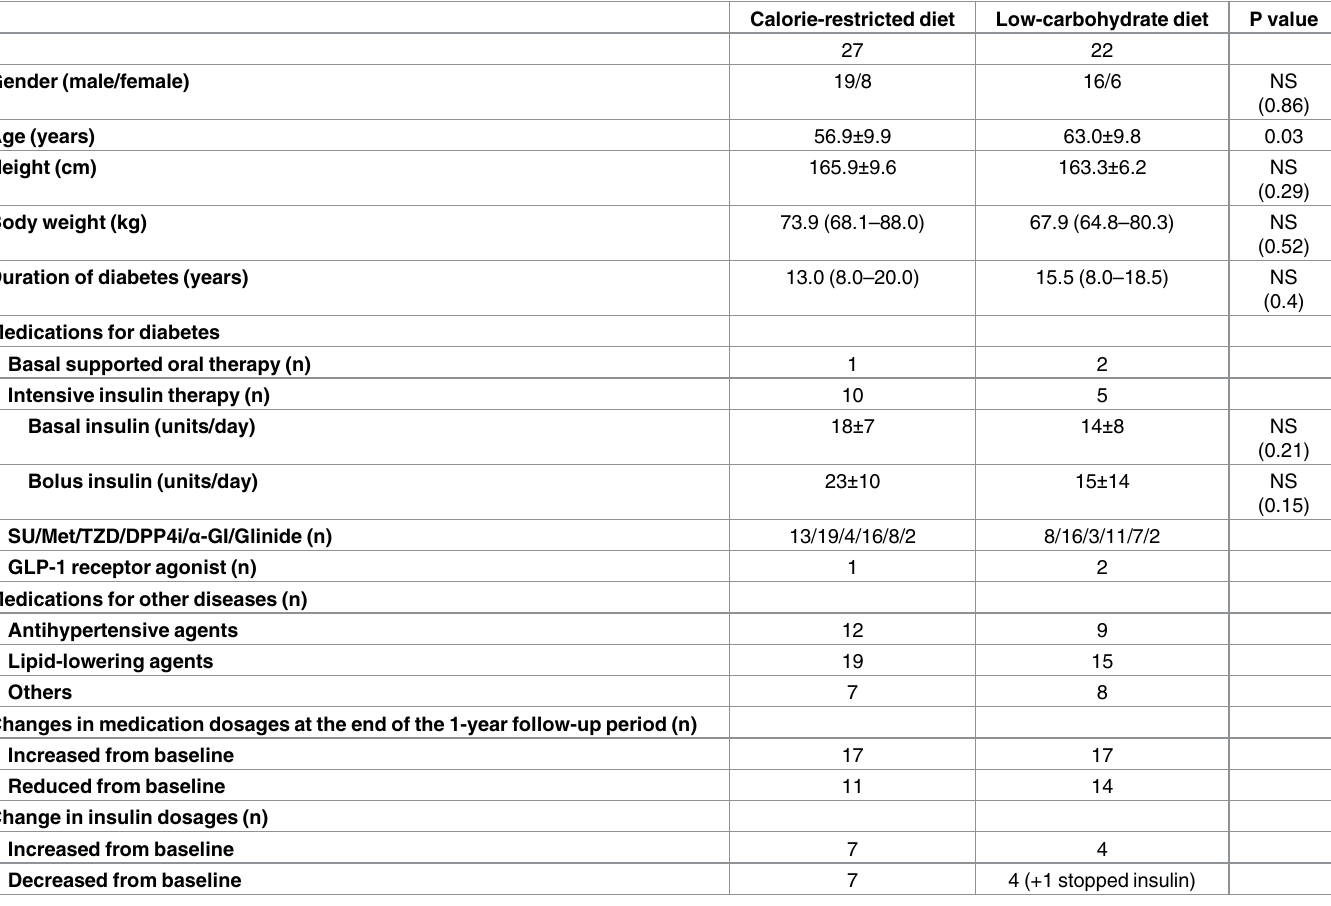
Table 1. Characteristics of 49 patients at the RCT baseline, and changes in medication dosages at the end of 1-year follow-up.